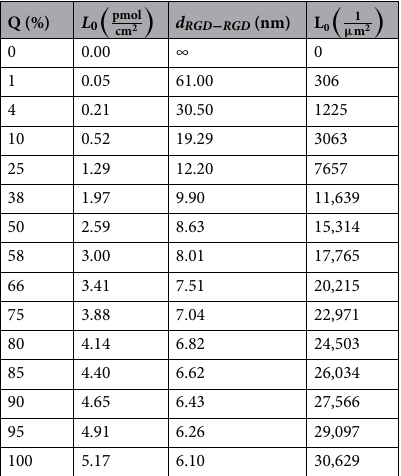
Table 1. Parameters of the fabricated RGD displaying surfaces using mixed PP:PPR